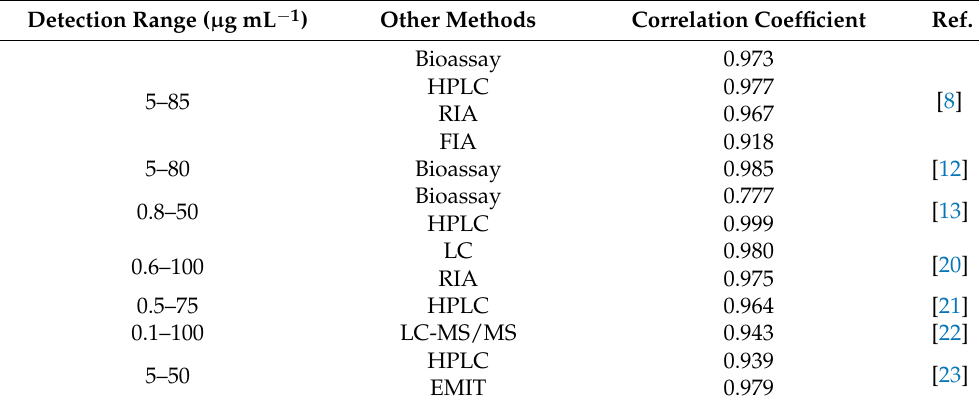
Table 2. Correlation analysis between FPIA and other